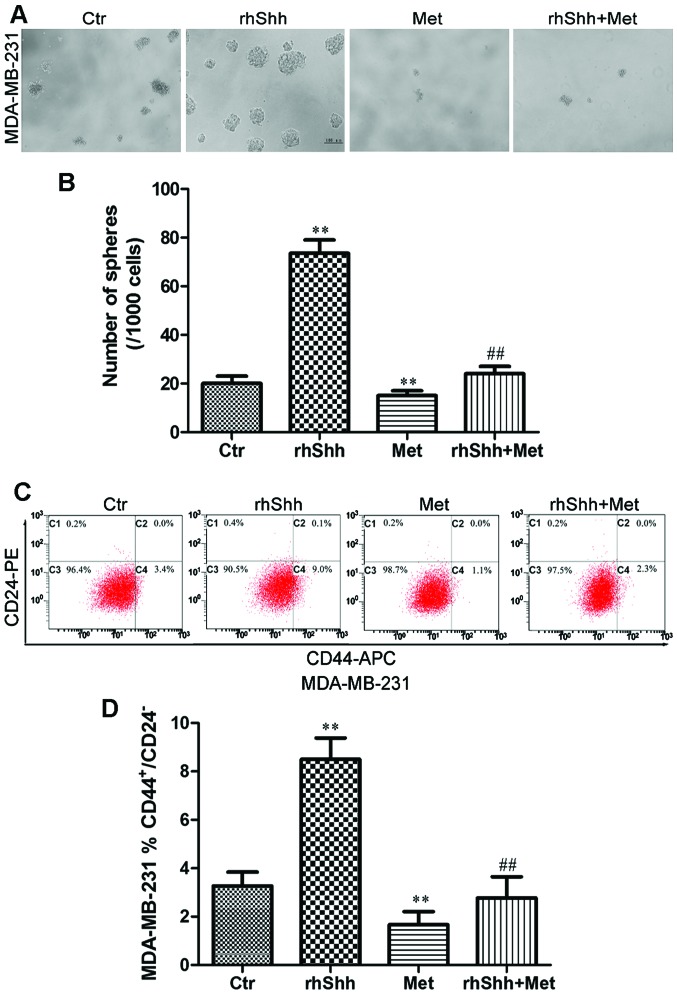
Metformin inhibits rhShh-induced sphere formation and reduces the number of CD44+/CD24− MDA-MB-231 cells. (A) Representative images of MDA-MB-231 cells in the presence of recombinant human Sonic hedgehog (rhShh), metformin and their combination. (B) The number of spheres was counted under a microscope. Data represent the means ± SD of 3 separate experiments (**P<0.01 vs. the Ctr group, ##P<0.01 vs. the rhShh group) (C) Cells were treated with rhShh, metformin and their combination. After 4 days, the cells were stained with anti-CD44-APC and anti-CD24-PE antibodies, and the CD44+/CD24− subpopulations were examined by flow cytometry. (D) Histogram illustrates the percentages of the CD44+/CD24− subpopulations. All data represent the means ± SD of 3 separate experiments (**P<0.01 vs. the Ctr group, ##P<0.01 vs. the rhShh group).